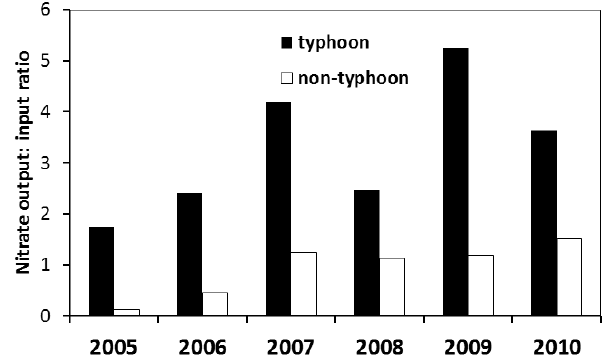
Fig. 6. The output: input ratio of NO 3 − during typhoon- and non- typhoon periods between 2005 and